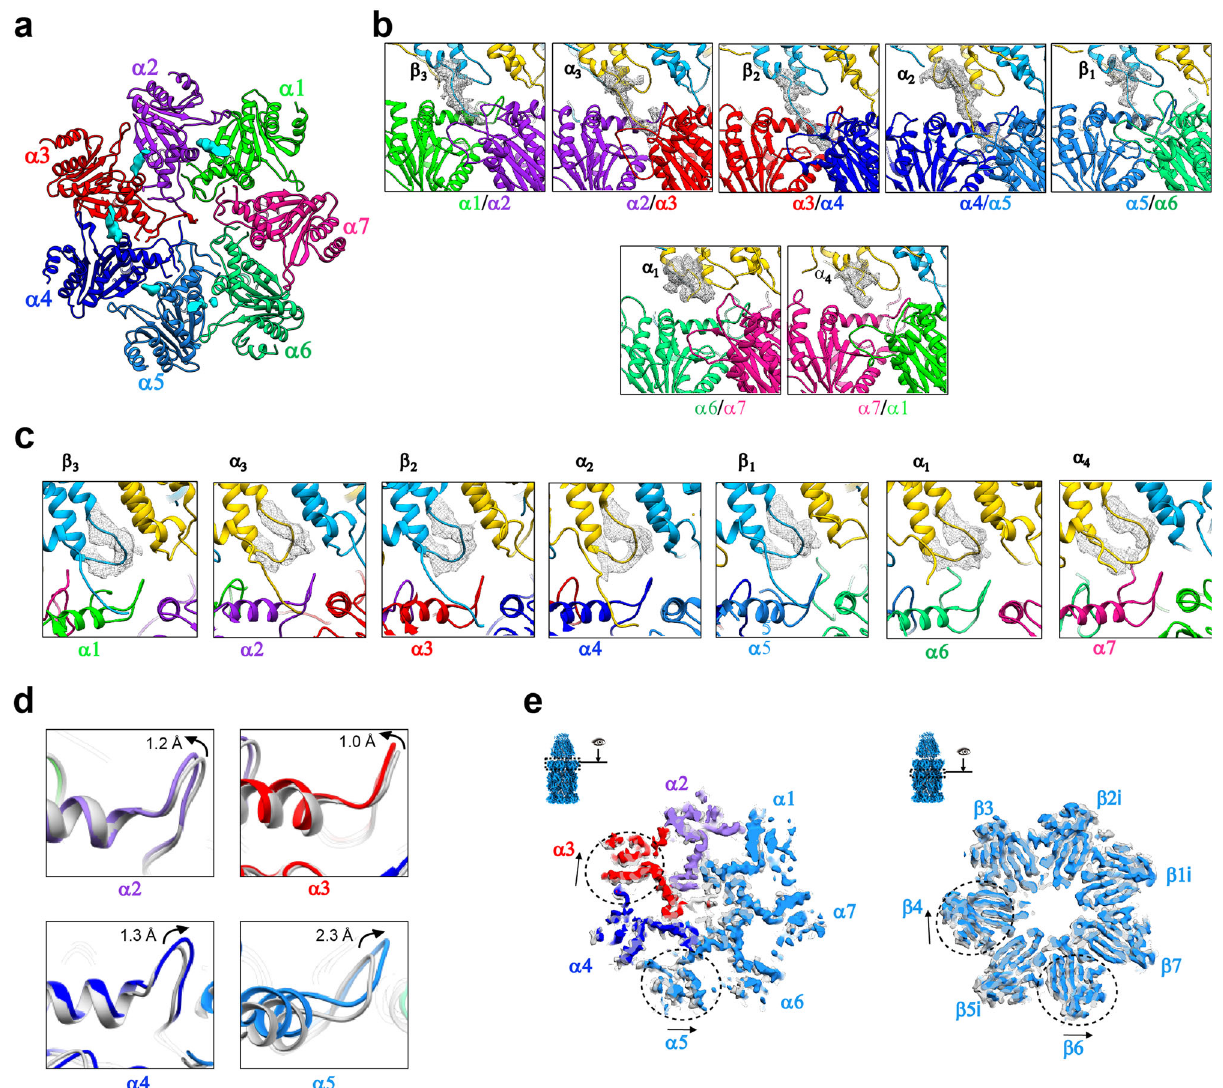
Fig. 3 Major interactions between PA28 αβ and iCP and the induced conformational changes of iCP. a Top view of the iCP α -ring with the inserted C- terminal tails of PA28 αβ (cyan pieces of density) for the PA28 αβ -iCP complex. b Magni fi ed views of the insertions of PA28 αβ C termini into the iCP α -ring pockets for the PA28 αβ -iCP complex, with the C-tail density shown as gray wire. The color schemes are as in Fig. 2b and are followed throughout. c The activation loop status of PA28 αβ (the loop density shown as gray wire) in the PA28 αβ -iCP complex. d Conformational changes of the reverse turns induced by PA28 αβ association in the PA28 αβ -iCP complex, determined by aligning the models of PA28 αβ -iCP (in color) with that of the free iCP (gray). Black arrow indicates the shift direction. e Superpositions of the cis α -rings (left) and β -rings (right) of PA28 αβ -iCP (with color) and the free iCP (gray), showing their conformational differences. Dashed circles indicate the regions with considerable conformational changes between the two structures, and arrows show the direction of conformational switches. The visualization angle and region are illustrated in the